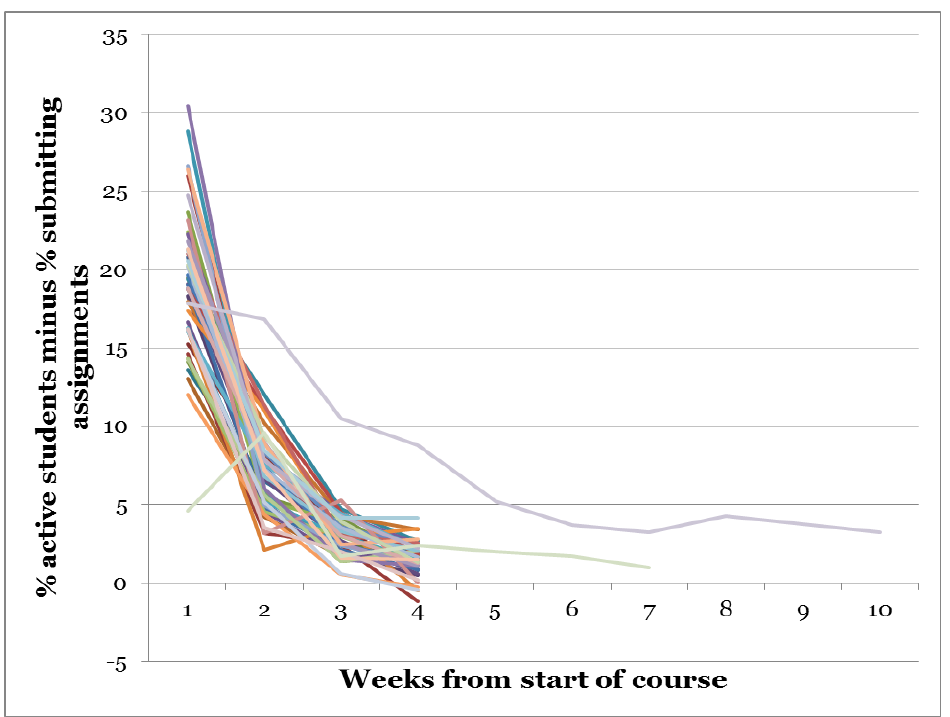
Figure 7. Difference between percentage of active students and percentage of students submitting assignments per week since the start of courses as a percentage of total enrolment